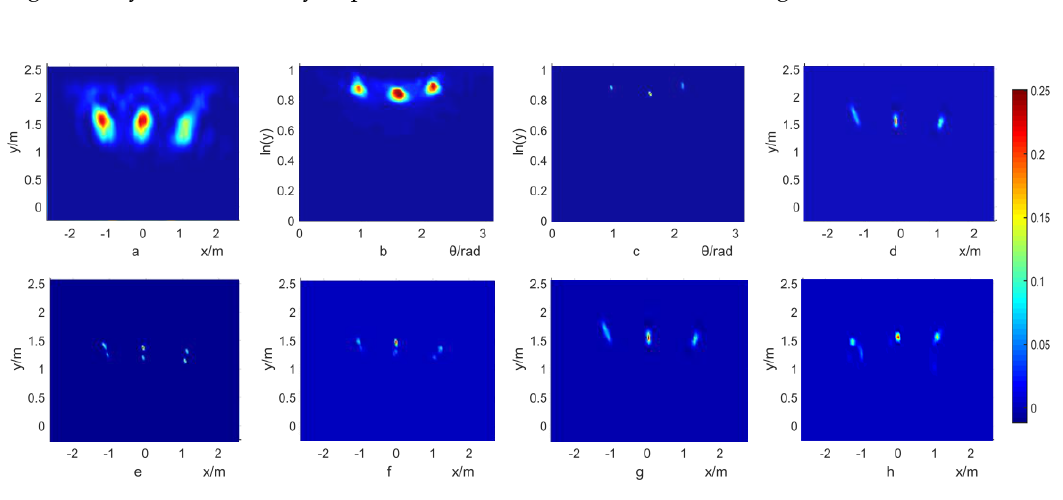
Figure 10. ( a ) blur image; ( b ) after log-polar transformation; ( c ) result of L-R method; ( d ) final result; ( e ) result of direct L-R method; ( f ) polar transformation with L-R method; ( g ) log-polar transformation with L-R method; ( h ) segmentation with L-R